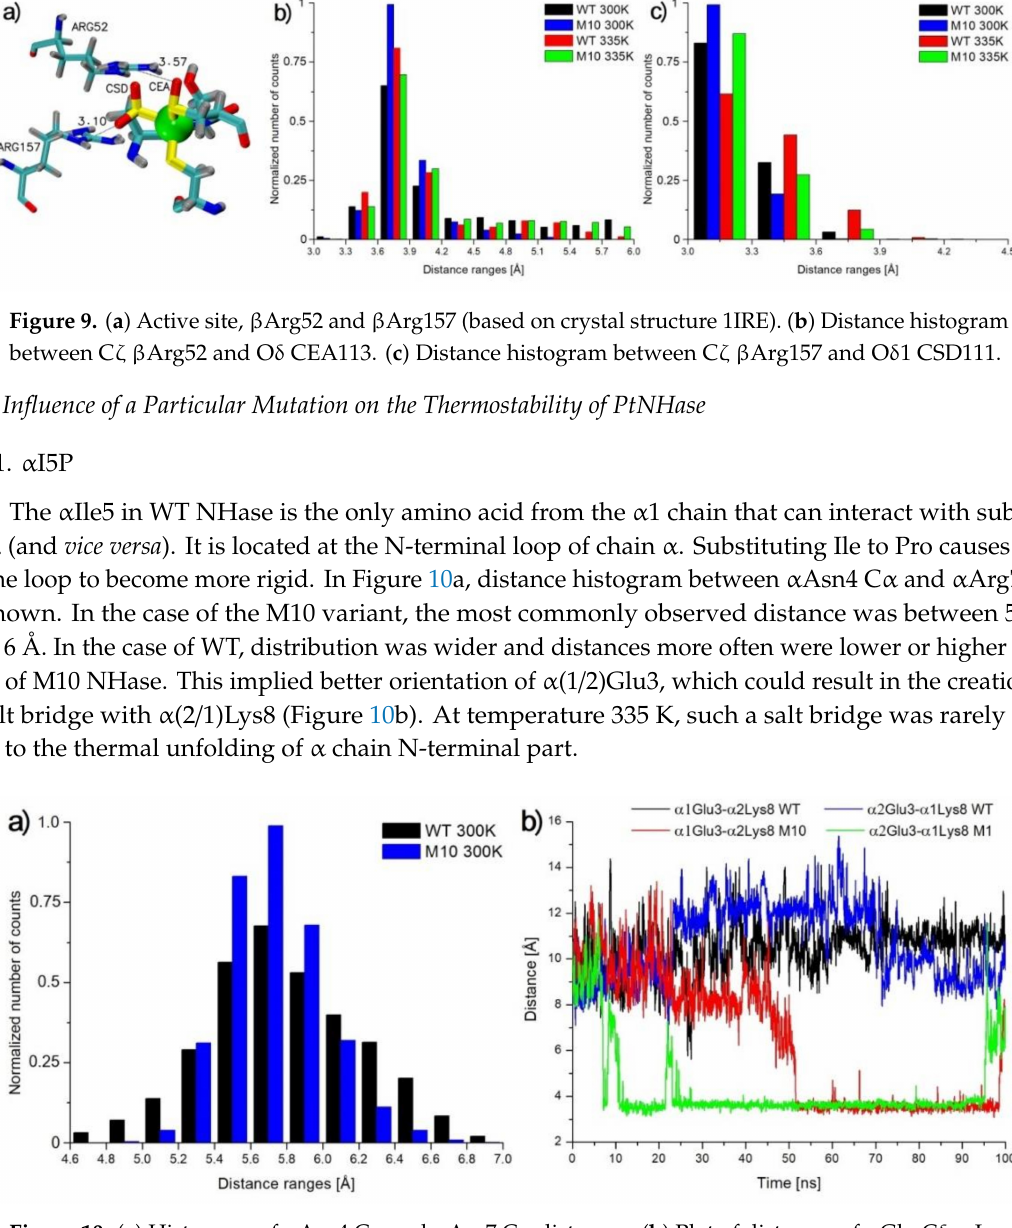
Figure 10. ( a ) Histogram of α Asn4 C α and α Arg7 C α distances. ( b ) Plot of distances of α Glu C δ – α Lys N ζ in 300 K MD